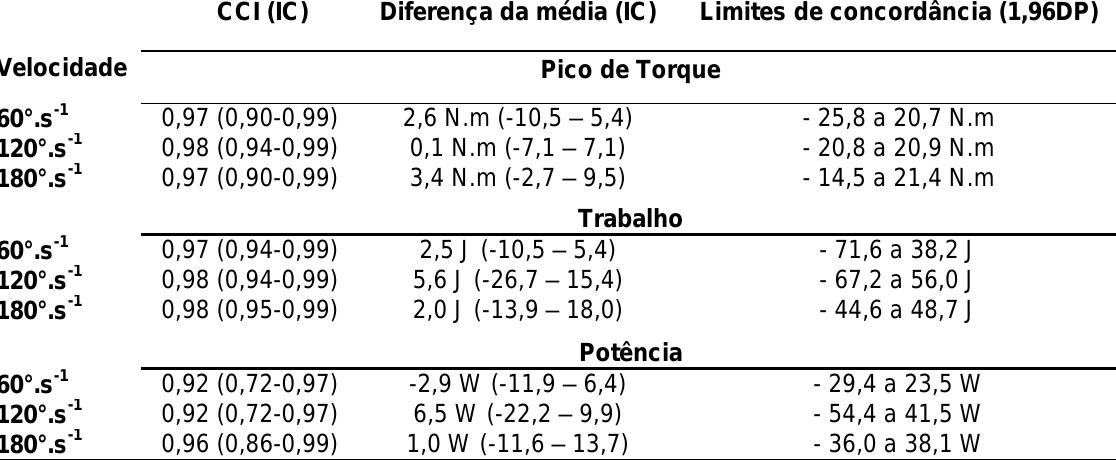
Tabela 2 . Valores dos coeficientes de correlação intra-classes (CCI), diferença das médias entre o T1 e RT, e limites de concordância de Bland e Altman, para cada